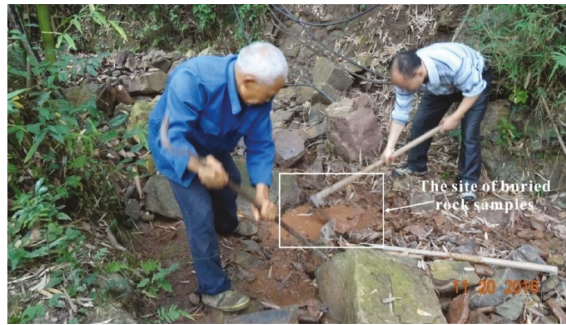
Figure 22: The process of the fi eld